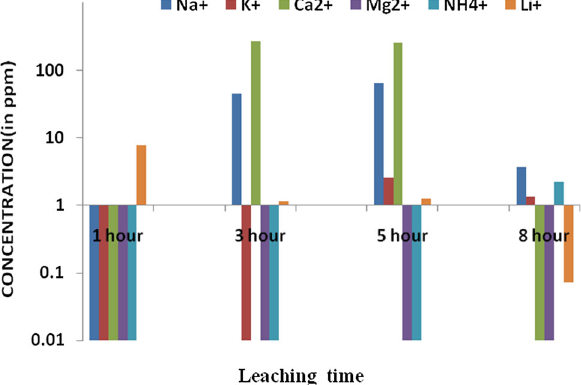
Fig. 3 Change in concentration (in ppm) of cations in aqueous leachates of Ledo coal (LC-20A) with leaching time (in hour) at 25 (cid:3) C